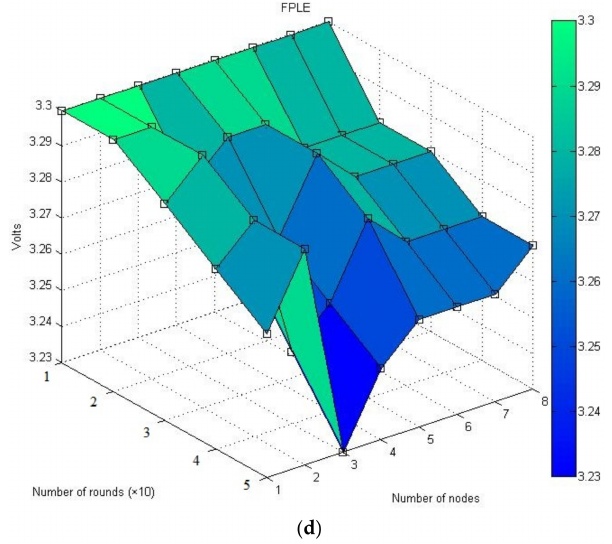
Figure 11. Battery Terminal voltage for every ten rounds of ECG signal by SingleHop, MultiHop, ATTEMPT and FPLE algorithms. ( a ) SingleHop; ( b ) MultiHop; ( c ) ATTEMPT; ( d ) FPLE. Table 5. Protocol